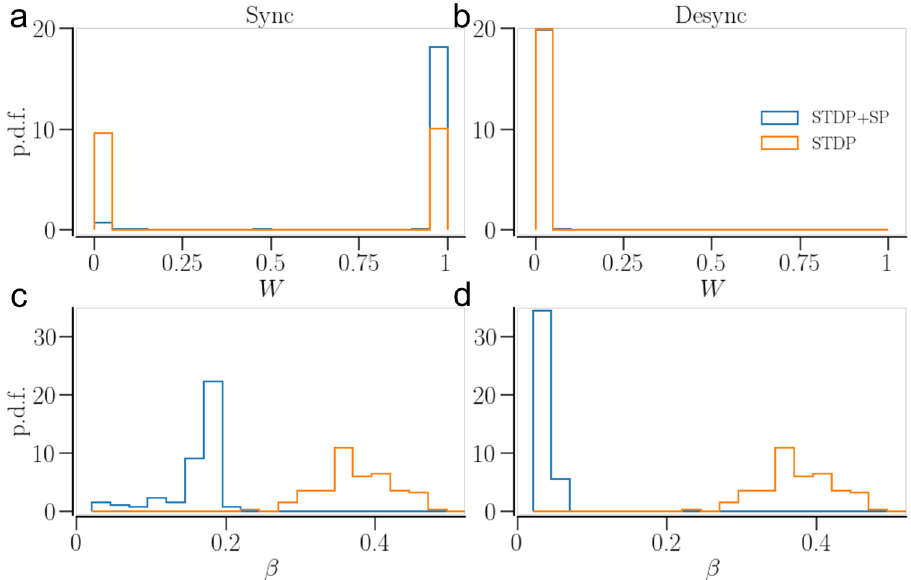
Figure 9. Statistics of synaptic weights and In-NDD for a network of non-identical oscillators in the asymptotic states belonging to the two plasticity schemes, STDP and STDP + SP. ( a ) and ( b ) show the synaptic weight distributions in a synchronized and a desynchronized state, respectively; ( c ) and ( d ) show the distributions of In-NDD in a synchronized and a desynchronized state, respectively. Parameters are a = 0.3 and γ = 15 . Initial conditions for the synchronized states are β( 0 ) = 0.4 and � W � ( 0 ) = 1 ; and for Desync (STDP): β( 0 ) = 0.4 and � W � ( 0 ) = 0.06 ; for Desync (STDP + SP): β( 0 ) = 0.2 and � W � ( 0 ) = 0.2